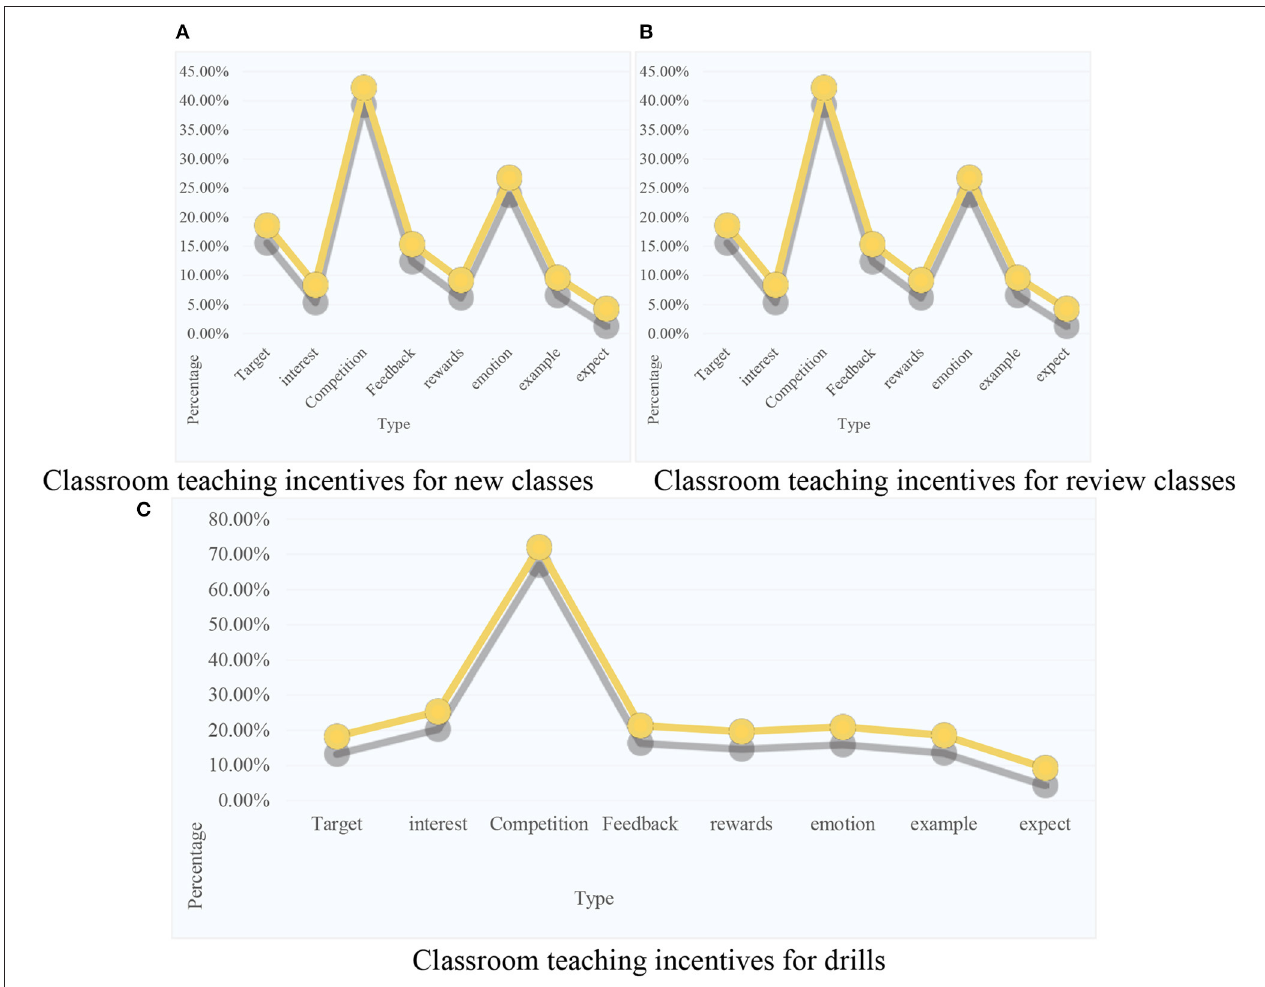
FIGURE 9 | Classroom teaching incentives in various types of courses. (A) Classroom teaching incentives for new classes. (B) Classroom teaching incentives for review classes. (C) Classroom teaching incentives for